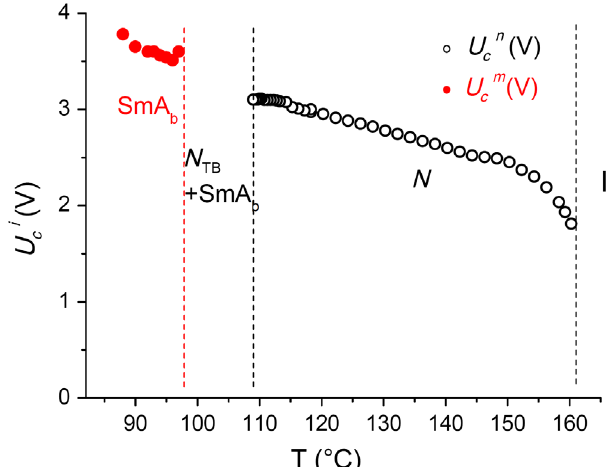
FIG. 11. Temperature dependence of the Fr´eedericksz transi- tion threshold in the N and Sm A phases. (There is no b Fr´eedericksz transition in the N phase, and no data are TB = Sm A available for the biphasic N range due to the nonuni- b TB form cell